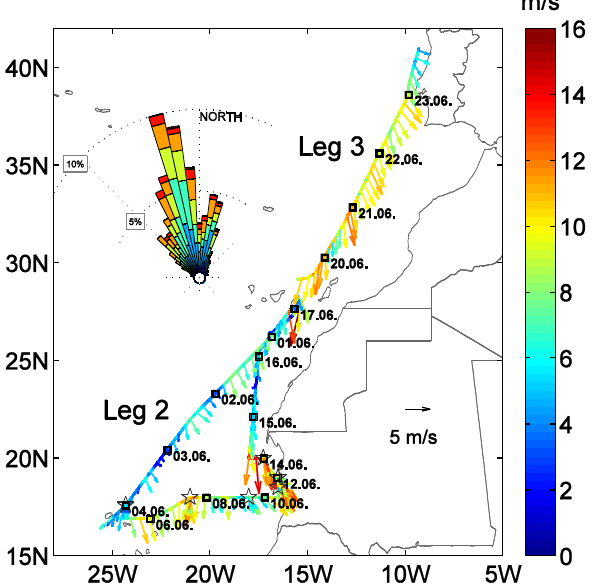
Fig. 1: DRIVE cruise track. In addition, the 3 hourly wind speed [m/s], direction (10 minute 665 Fig. 1. DRIVE cruise track. In addition, the 3-hourly wind speed averages) and windrose for the whole cruise are shown. 666 [ms − 1 ], direction (10min averages) and windrose for the whole cruise are shown.